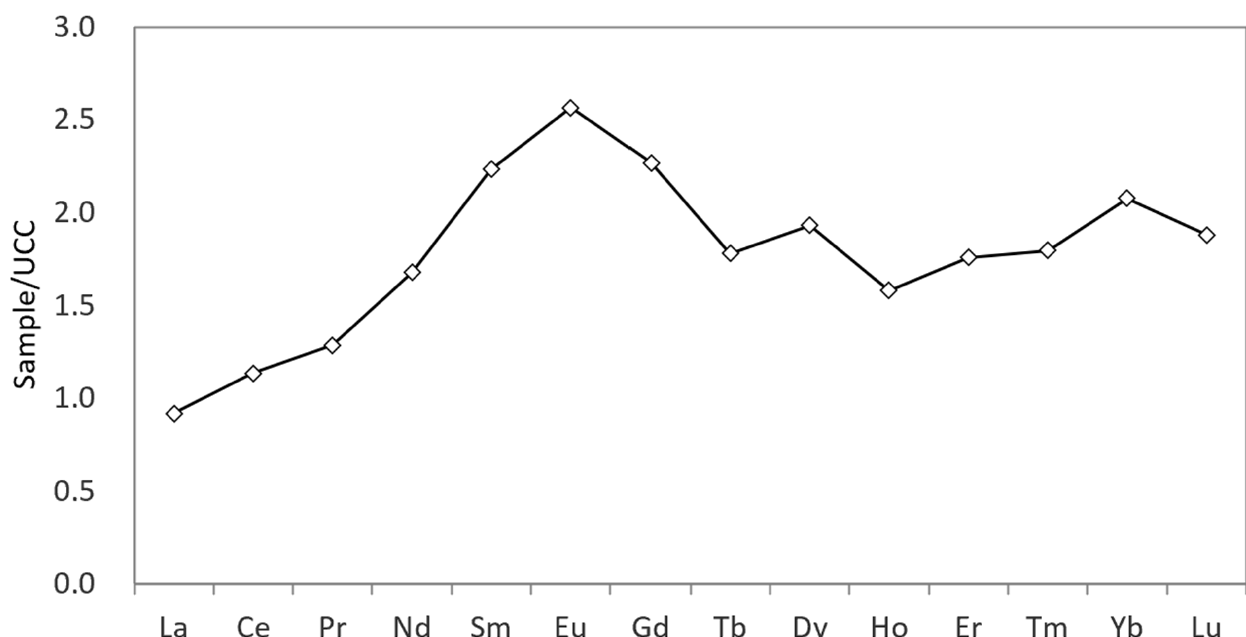
Figure 5. The Upper Continental Crust (UCC)-normalized REE distribution in lignite of the Nizhne- Kas area.